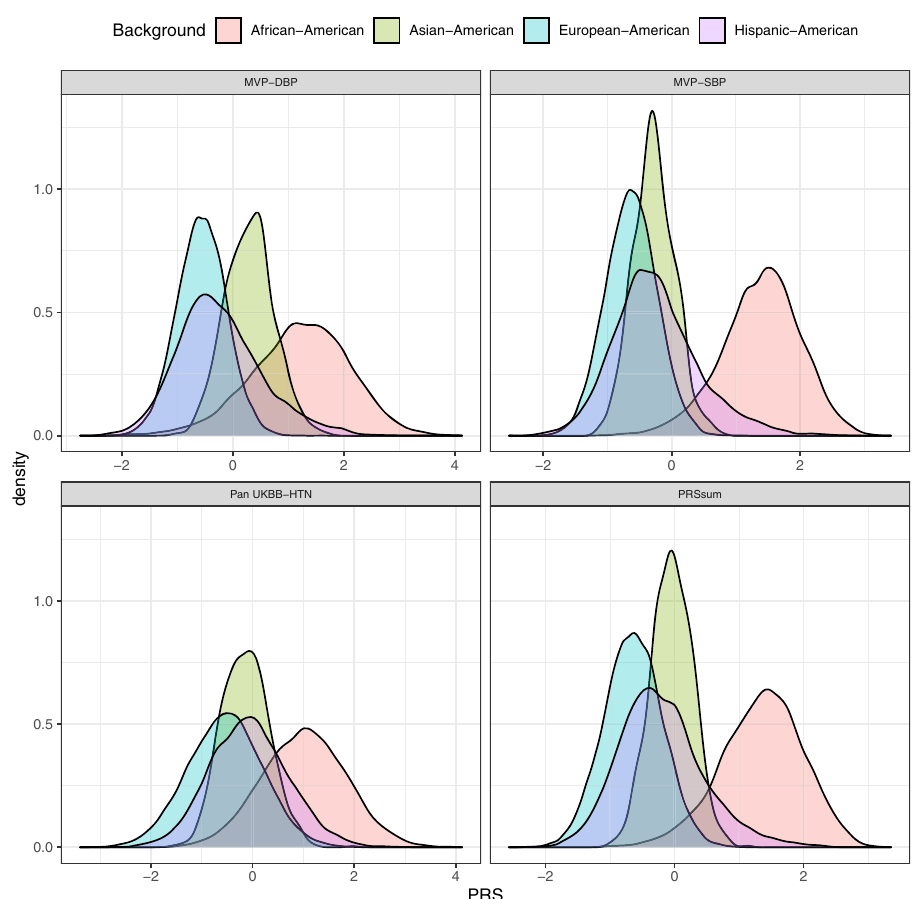
Fig. 3 PRS distribution strati fi ed by race/ethnic background. Density plots showing the distributions of Selected CV-PRS based on each GWAS used (Table 1) and PRSsum constructed by summing Selected CV-PRS from the three GWAS (the fi nal HTN-PRS). The fi gure was created using the stage 2 dataset. The densities are strati fi ed by race/ethnic